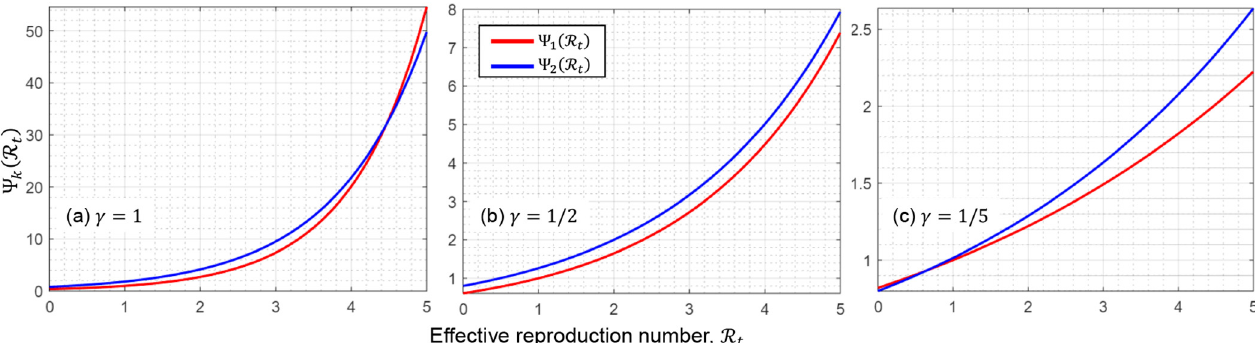
Fig. 5. The variation of C 1 ( R t ) and C 2 ( R t ) for R t with empirically estimated parameters describing COVID-19 outbreak: g = { 1, 1/2, 1/5 } (both models), n =1/5, % = 1/10, z =0.116 and m =9.4/1000. Coverage: 1 – 11 September 2020 in the United Kingdom.